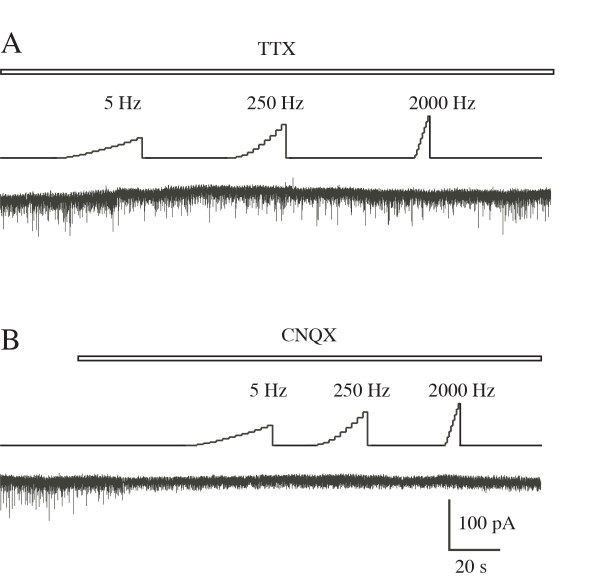
EPSCs in SG neurons recorded in the presence of TTX (1 μM, A) or CNQX (20 μM, B).